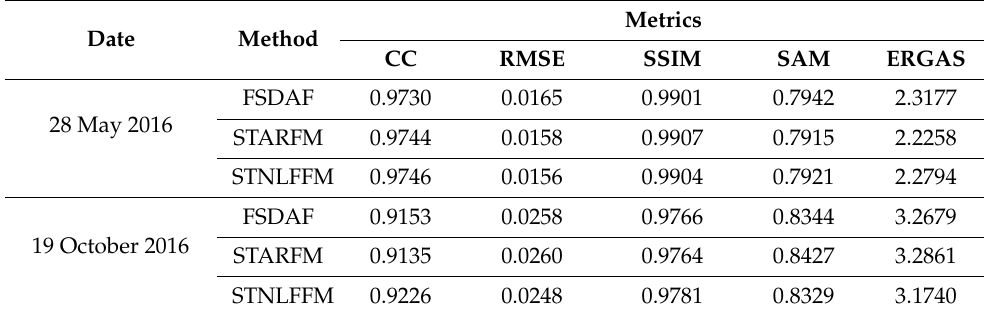
Figure 7. RGB composition of the fusion results. The first and second rows are the MCD43A4, Landsat 8 OLI imagery, and the fused images of the three different methods (STARFM, FSDAF, and STNLFFM) on May 28 and October 19, respectively. Table 6. Quantitative evaluation of spatiotemporal fusion